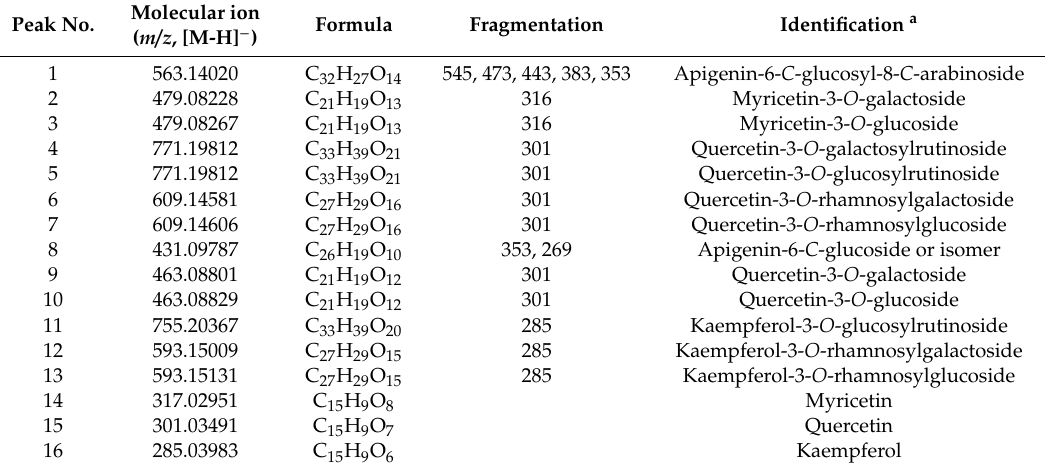
Figure 2. HPLC chromatograms of the fractions rich in ( A ) flavonol glycosides (FLG) and ( B ) flavonol aglycones (FLA) at 365 nm. Refer to Table 1 for identification of each numbered peak of the 16 phenolics. Table 1. Identification of individual phenolics in the fractions rich in flavonol glycosides and flavonol aglycones from green tea